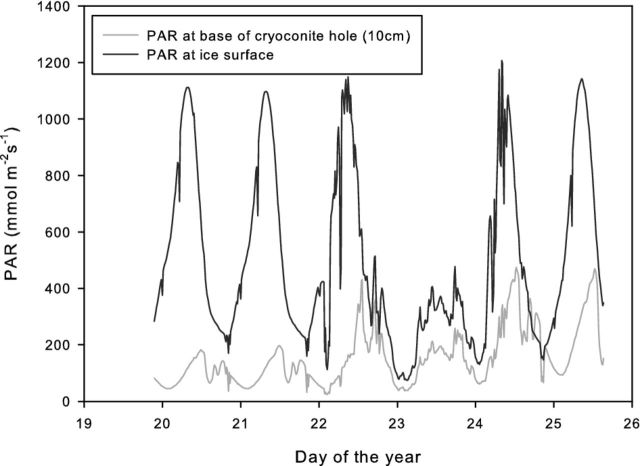
Comparison of PAR receipt at the ice surface of Canada Glacier (January 2010) with that at the bottom of a 10 cm deep, ice-lidded cryoconite hole. Smooth curves are indicative of clear skies. Note that peak PAR at the hole bottom lags that at the surface by 4.5 h and minimum PAR at the bottom either coincides or lags the PAR at the surface.